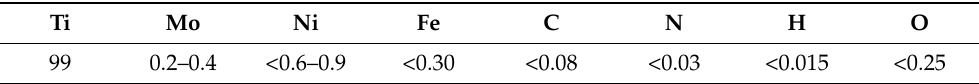
Table 1. Chemical composition of the TA10